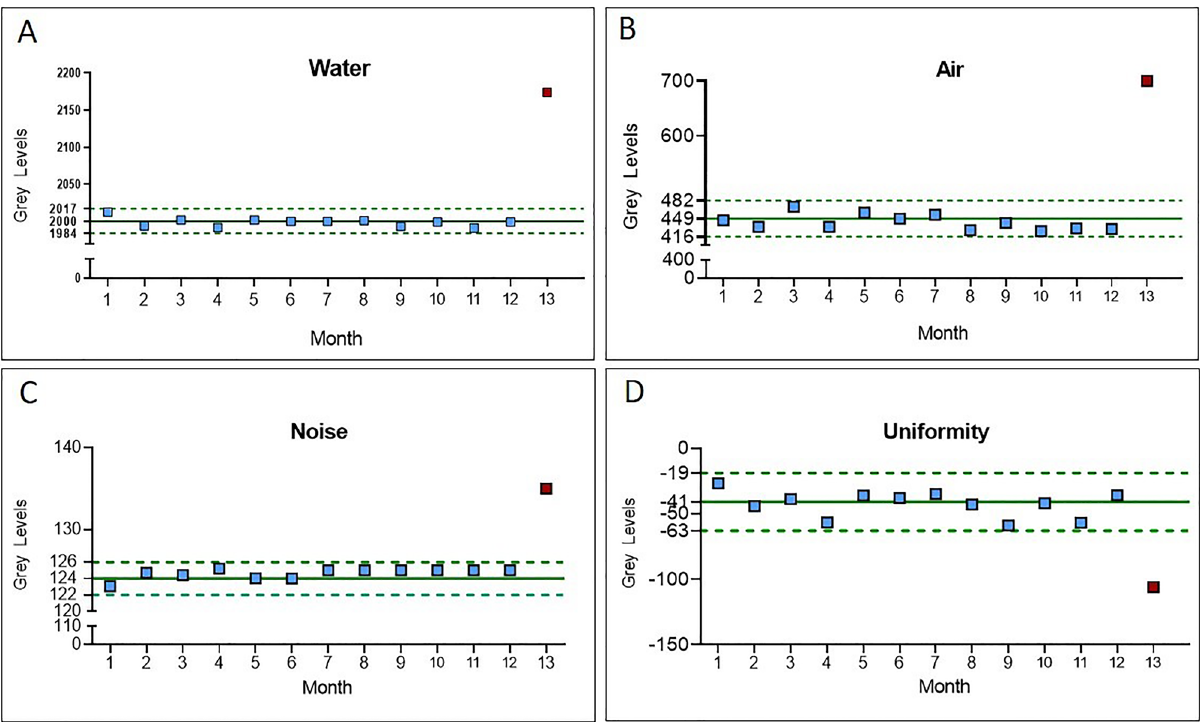
Figure 2. Control charts for Water and Air absolute grey levels ( A , B ) and Image noise and uniformity ( C , D ). The fluctuations of QC parameters were monitored during 13 months. BL values (continuous lines) and acceptability ranges (dotted lines) are highlighted in green for each control